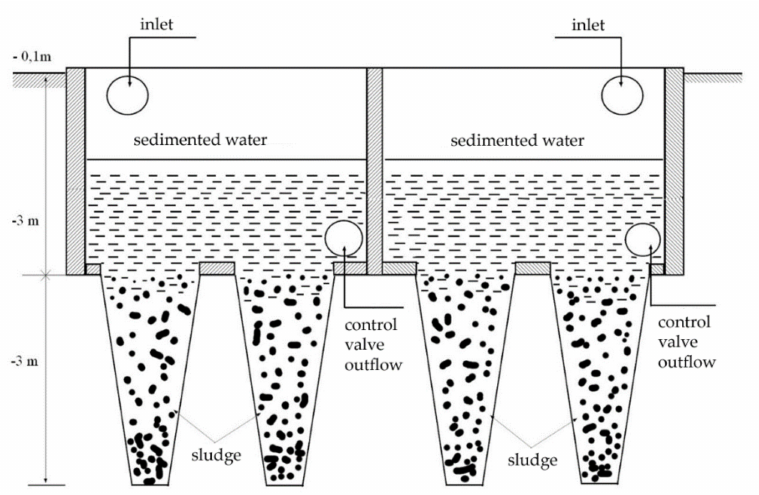
Figure 1. Scheme of the designed sedimentation tank and its